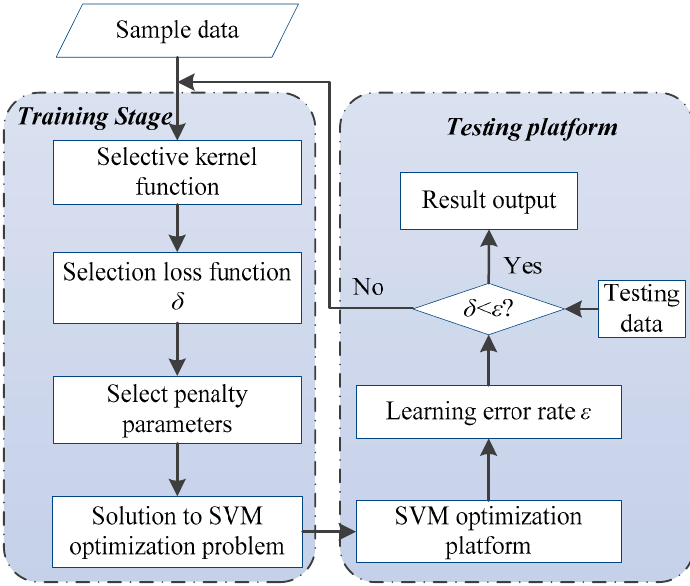
Figure 4. SVM prediction model.